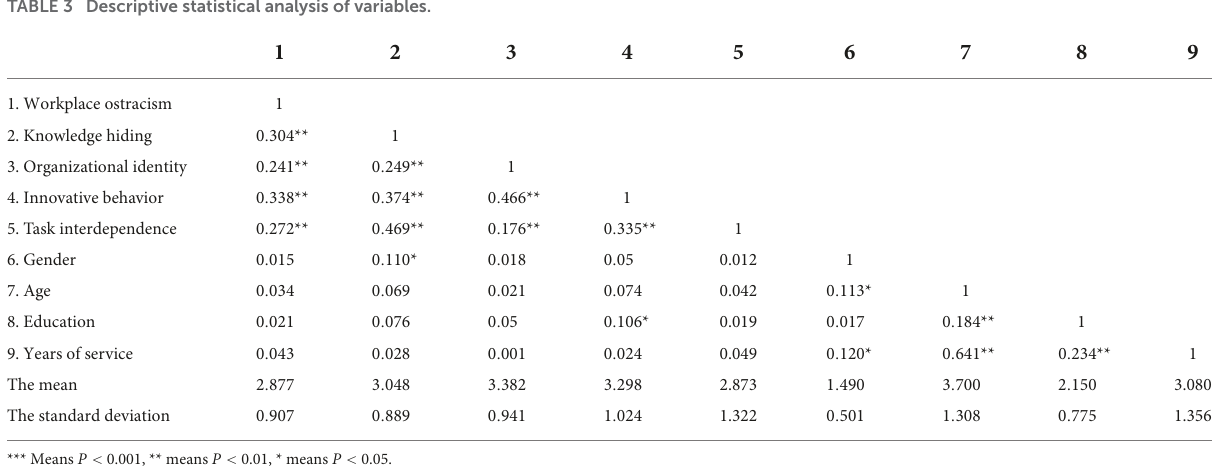
TABLE 4 Results of hierarchical regression analysis of innovation behavior.